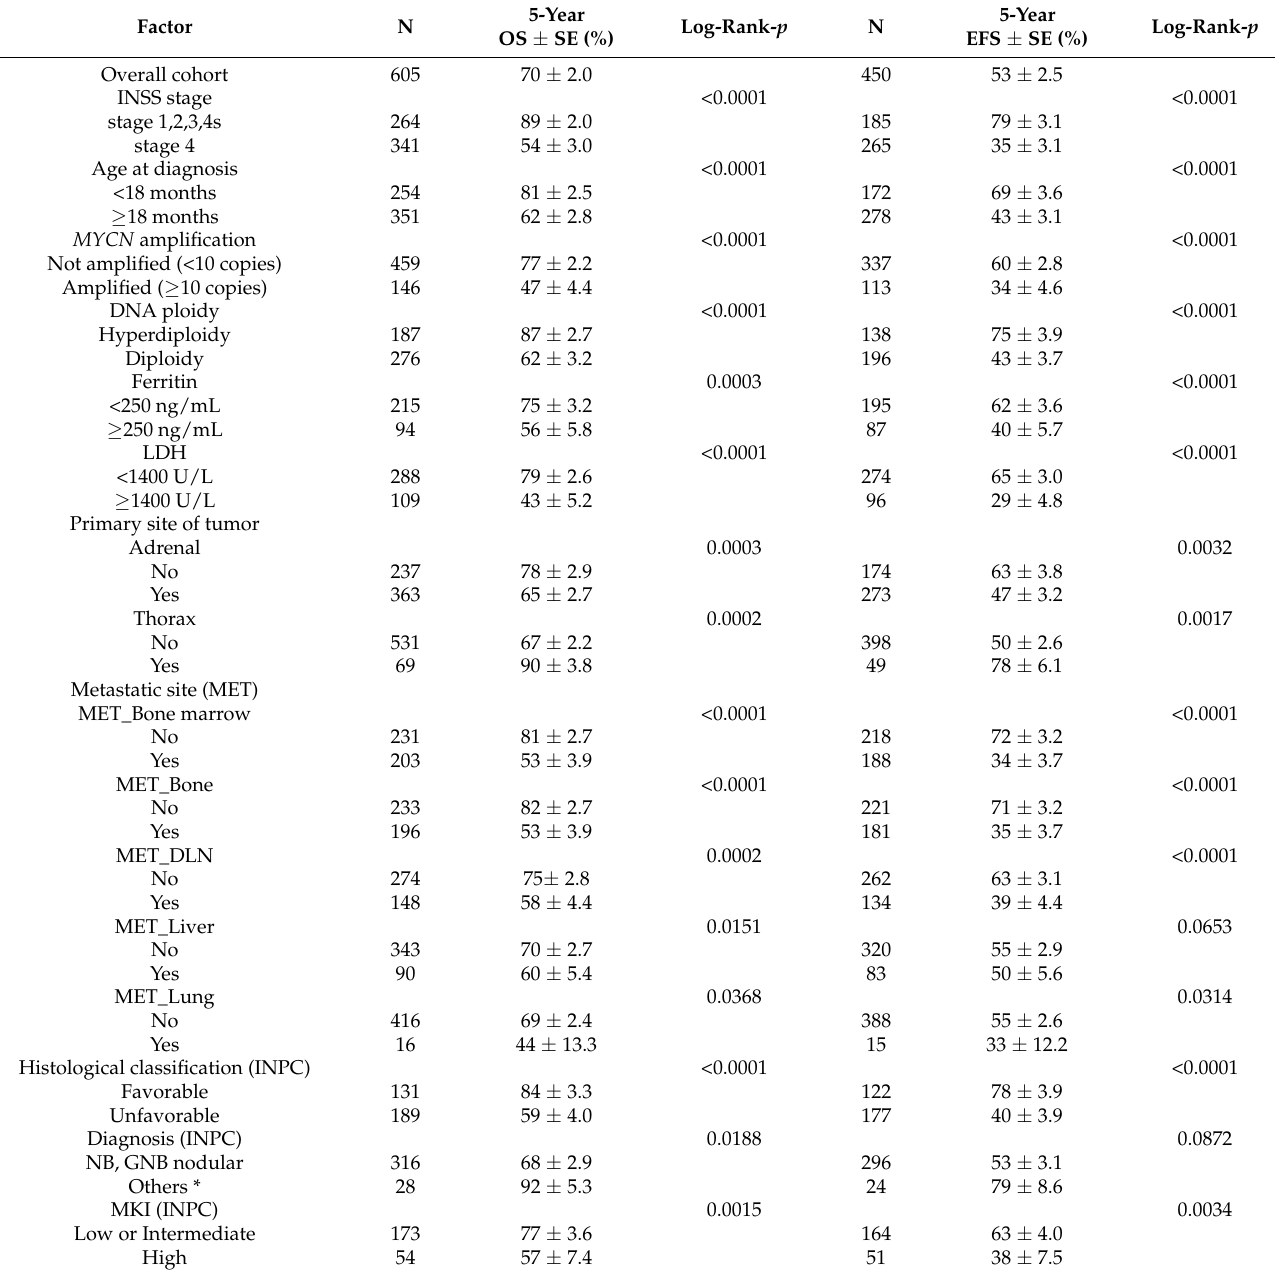
Table 1. Clinical characteristics of 605 JPN patients (5-year overall and event-free survival rates). Factor N Overall